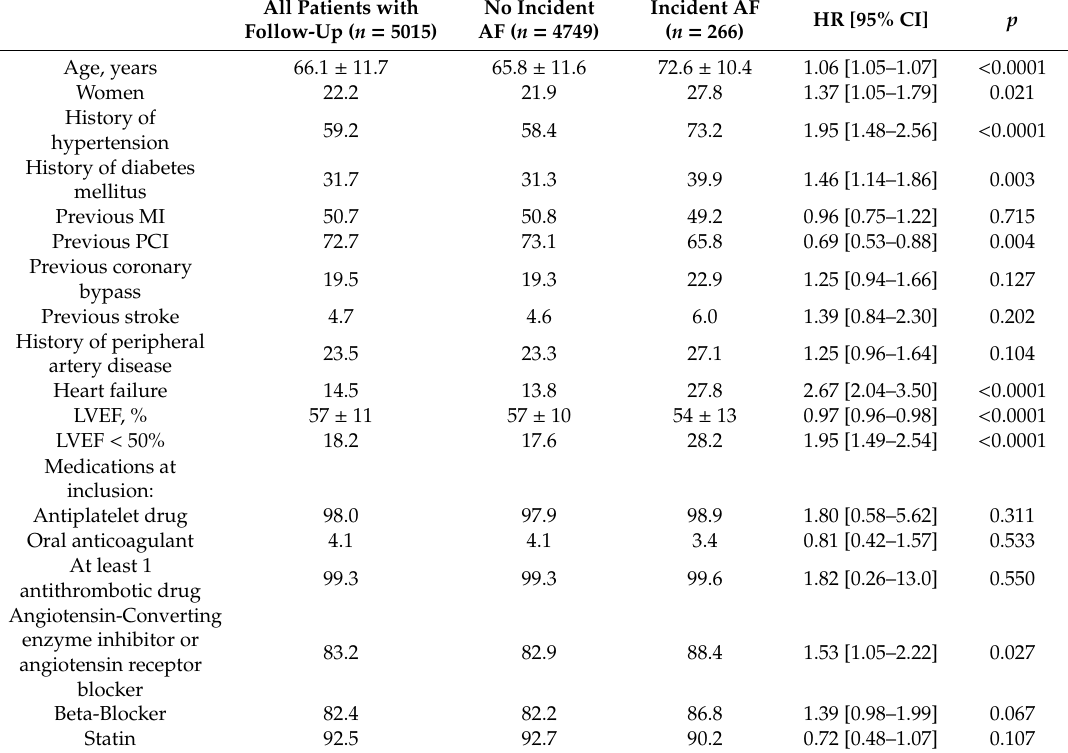
Table 1. Baseline characteristics of the study population and correlates of incident atrial fibrillation (AF) according to univariable analysis. All Patients with Follow-Up ( n =